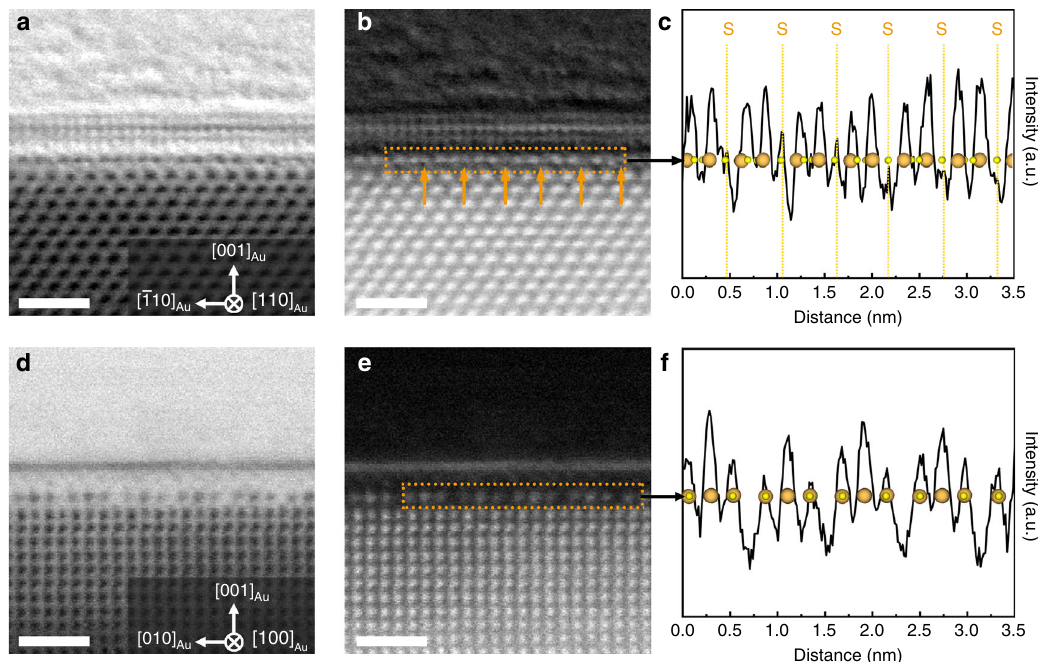
Fig. 6 Characterization of S atom occupation in the reconstructed Au (001) surface. a ABF-STEM image viewed from the [110] Au direction. Scale bar, 1 nm. b Contrast-inversed image of ( a ) showing the S atomic columns. Scale bar, 1 nm. c The corresponding intensity line pro fi le of the reconstructed layer from dotted box in ( b ). d ABF-STEM image viewed from the [100] Au direction. Scale bar, 1 nm. e Contrast-inversed image of ( d ) in which S atomic columns are invisible. Scale bar, 1 nm. f The corresponding intensity line pro fi le of the reconstructed layer from dotted box in ( e ). The orange and yellow spheres represent Au and S atoms,